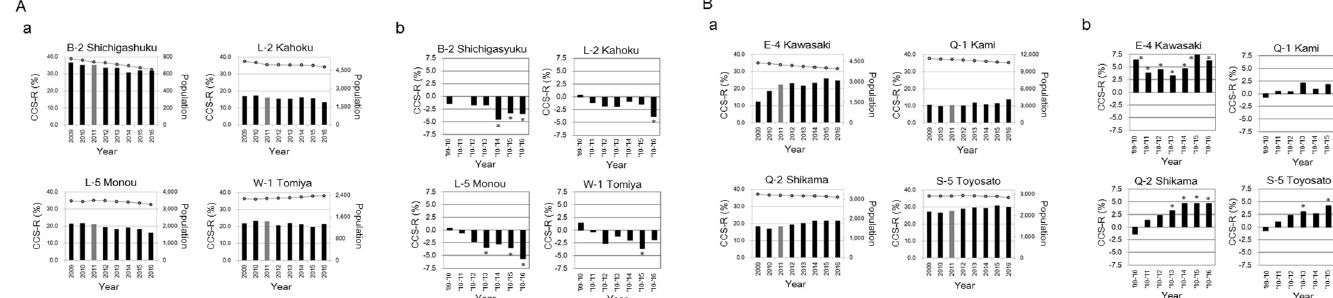
Fig 3. Change in the cervical cancer screening rate (CCS-R) in non-coastal areas examined in this study. (A) a. The CCS-R declined by more than 3.0% compared with that of the year before the earthquake (over − 3.0%). The bar graph shows the CCS-R (%), and the line graph shows the population (number of people). b. Differences in the CCS-R between before and after the Great East Japan Earthquake in each area demonstrated in “a”. � , change of 3% or more. (B) a. The CCS-R declined by more than 3.0% compared with that of the year before the earthquake (over +3.0%). The bar graph shows the CCS-R (%), and the line graph shows the population (number of people). b. Differences in the CCS-R between before and after the Great East Japan Earthquake in each area demonstrated in “a”. � , change of 3% or